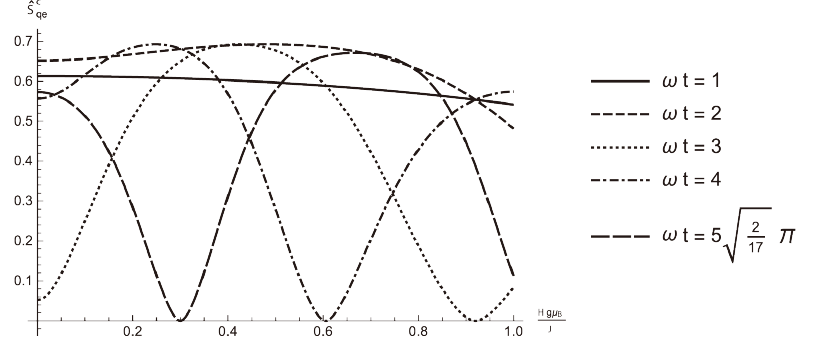
2 π . Here, 17 (cid:113) 2 π . Here, , 5 17 · · · q